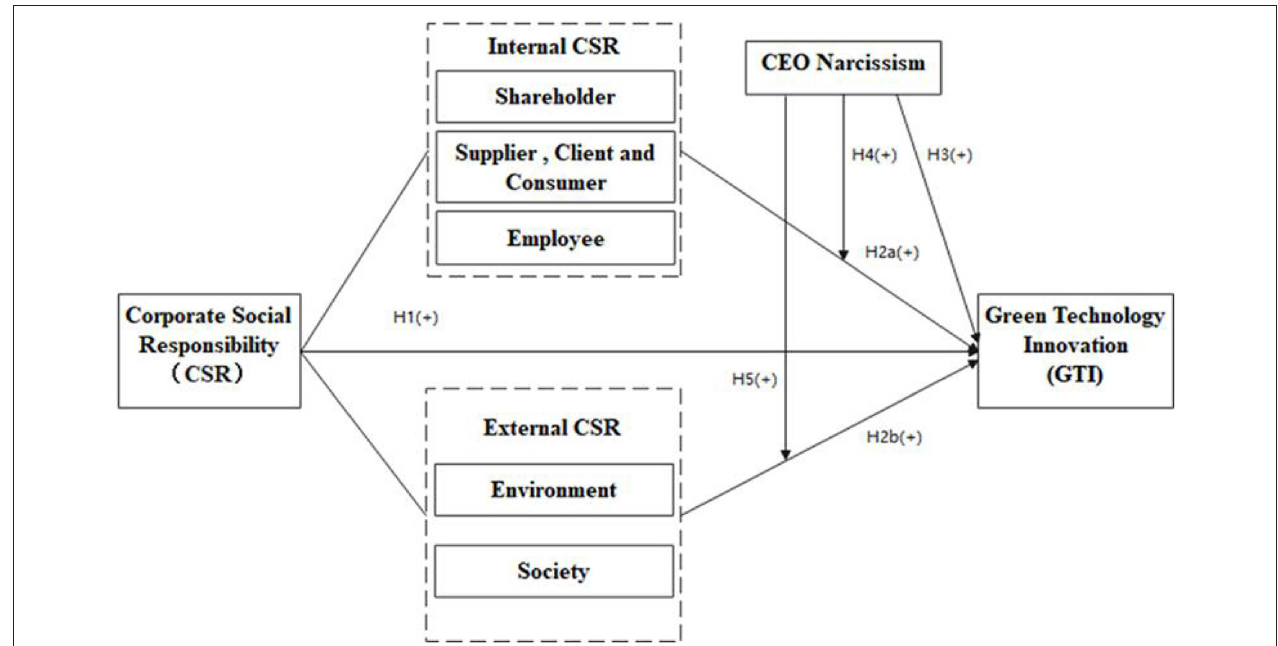
FIGURE 1 | Conceptual model of the